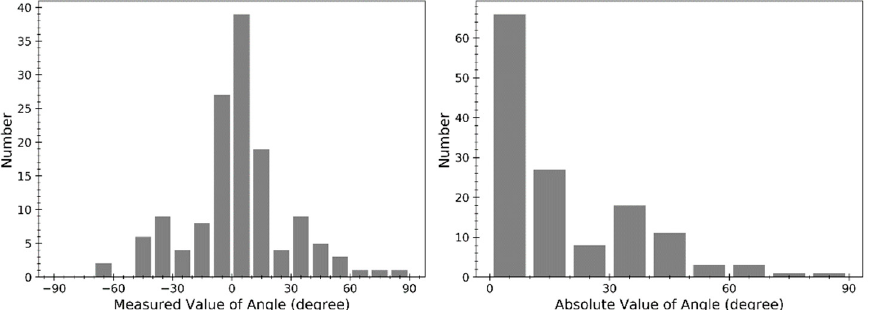
Figure 11. Distribution of the measured angles of the cores up to 50 m in depth through DSCope.